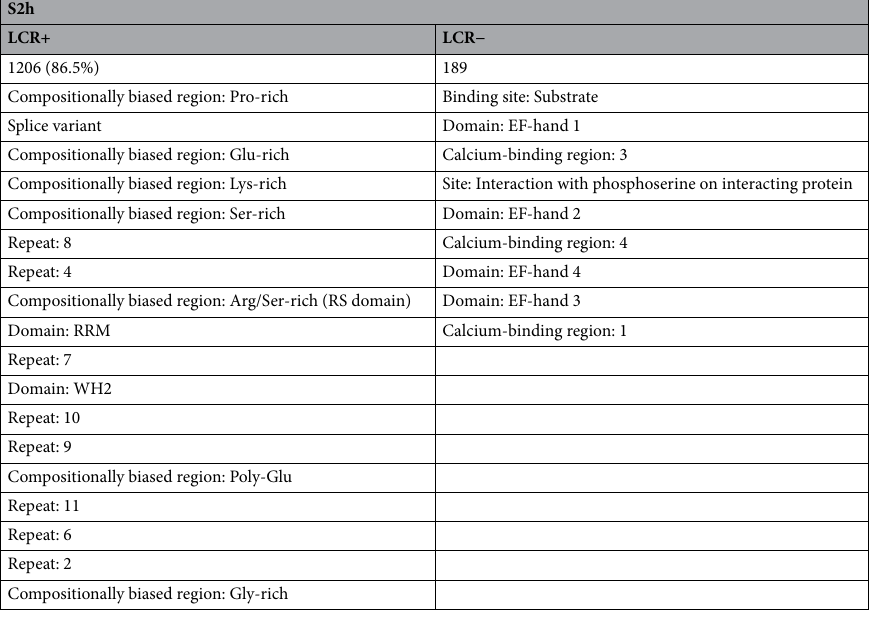
Table 3. The sequence features of S2h proteins, with and without LCRs, analyzed by DAVID. See Supplementary information 1 for each protein list.